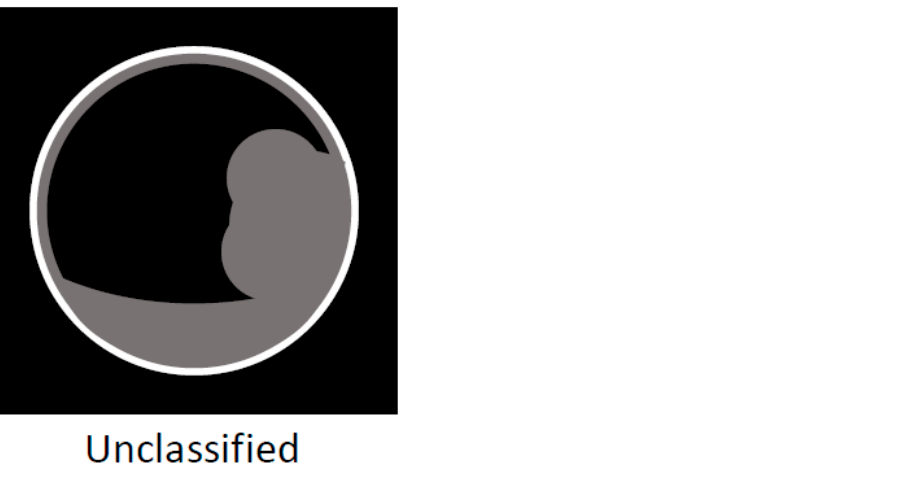
Figure 7. Schema of US/EUS findings in a localized type of IgG4-sclerosing cholecystitis: